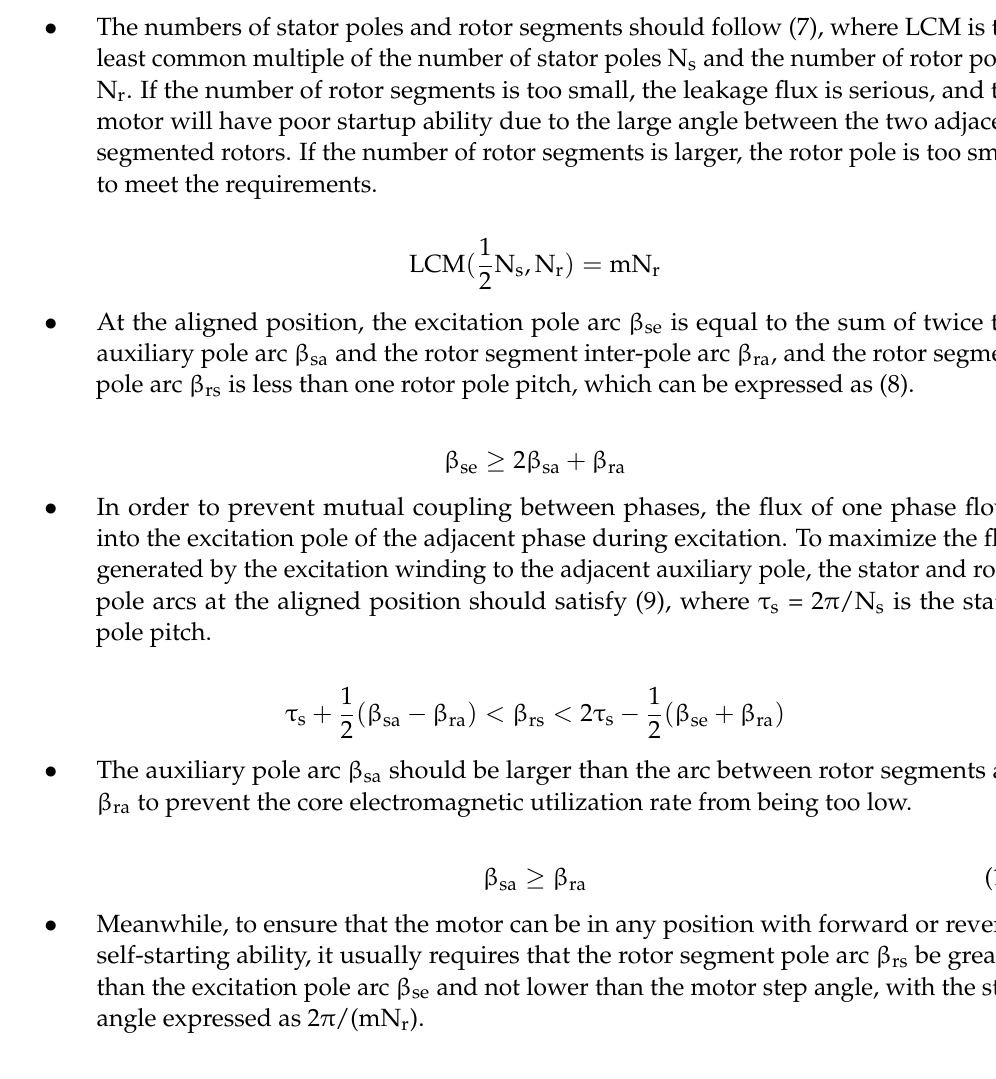
Figure 14. ( a ) Basic structure diagram of segmental rotors SRM with ST windings; ( b ) Reasonable constraint quadrilateral of SRM with segmental rotors. Notes: point a (2 π /(mN r ),2 π /N r ); point b (4 τ s -2 τ r ,2 π /N r ); point c (2 π /(mN r ), τ r (1-1/(3m))); point d (3 τ r /4, 3 τ r /4); point e (2 τ s - τ r /2, 2 τ s - τ r /2).